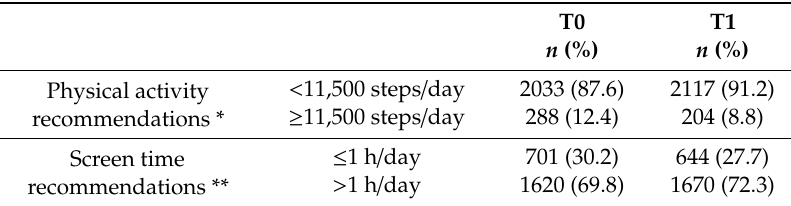
Table 2. Number (%) of European preschool children participating in the ToyBox study that met or did not meet the physical activity and screen time recommendations at baseline (T0) and follow-up (T1) ( n =